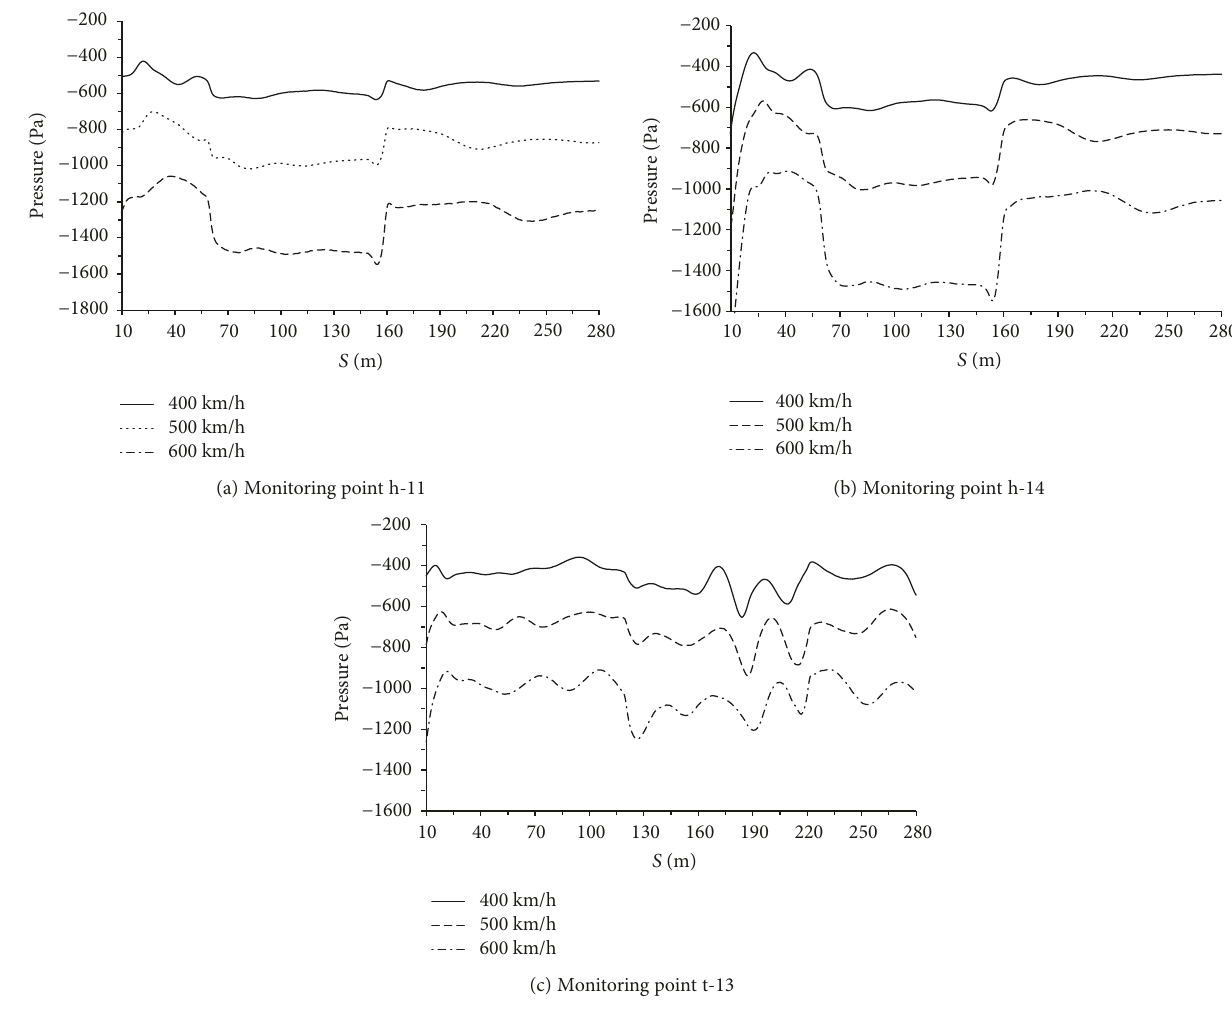
Figure 13: Comparison curves of pressures at di ff erent monitoring points under high-speed train passing the embankment air barrier.